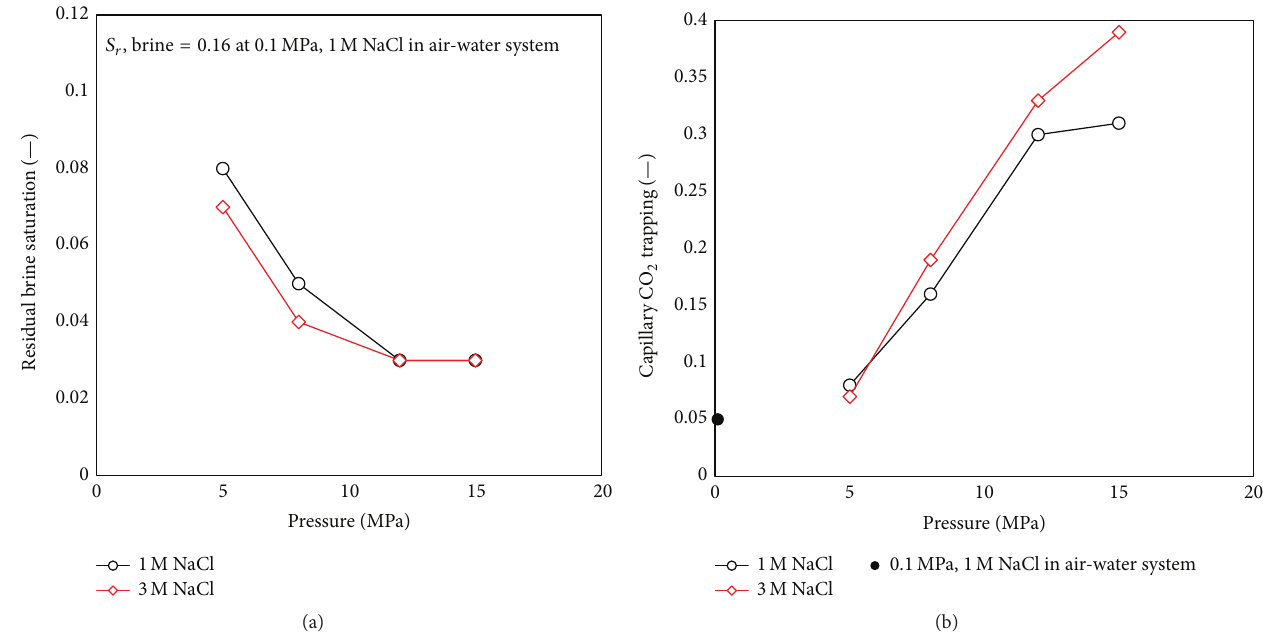
Figure 6: Residual brine and CO 2 saturation. (a) Residual brine saturation after drainage process and (b) capillary CO 2 trapping after imbibition